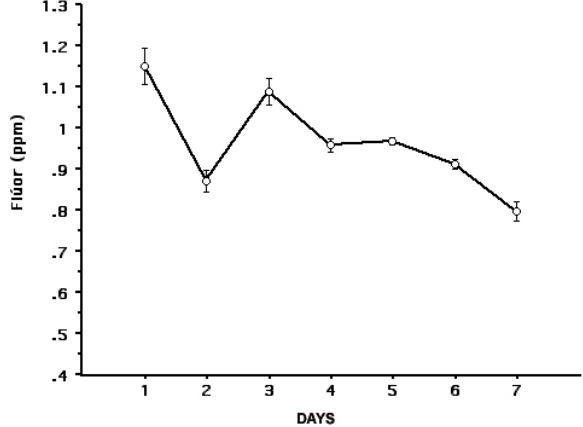
FIGURE 1- Mean fluoride concentration (ppm) in the drinking water of Penedo in 7 different days.